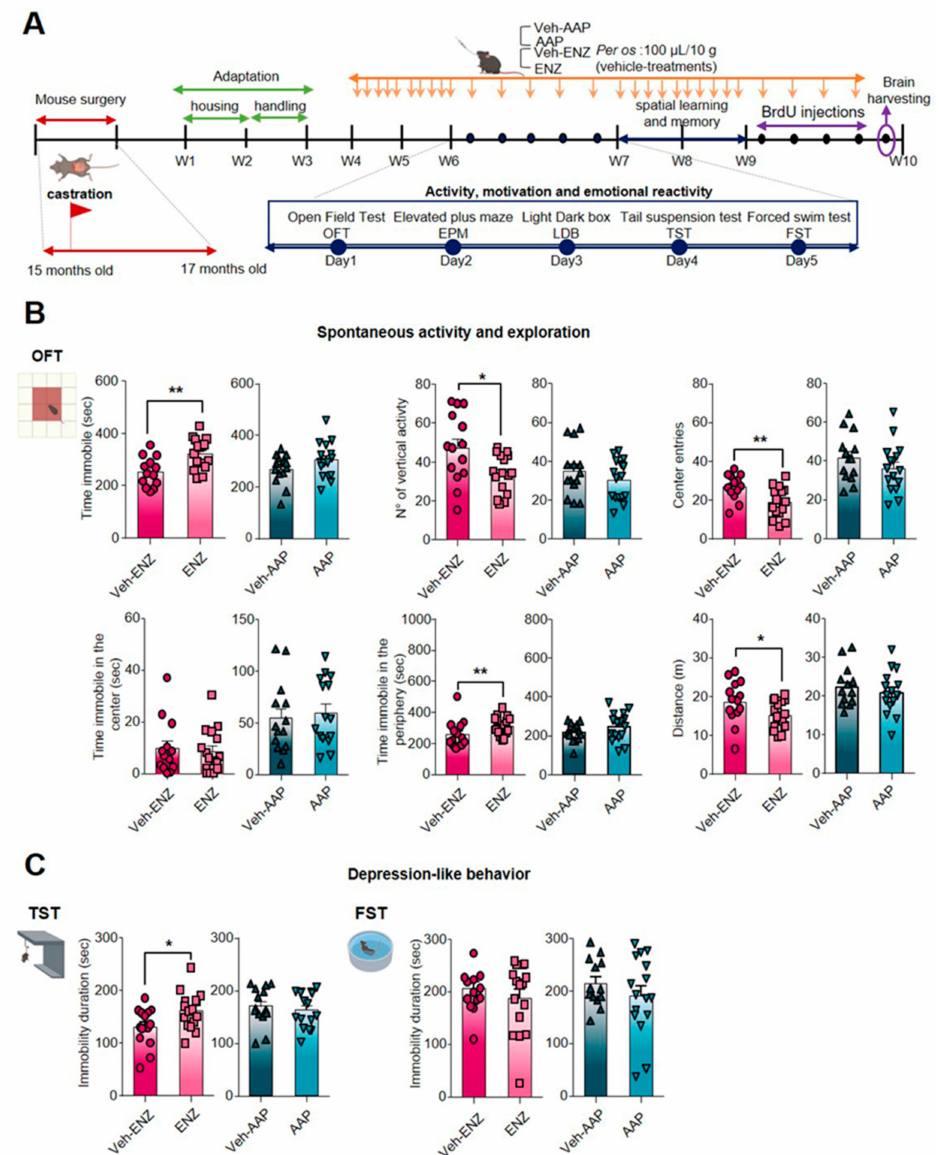
Figure 2. Characterization of ENZ or AAP impact on incentive exploratory behavior and motivation to the effort of mice. Note. ( A ) Schematic diagram showing the timeline for treatments and behavior experiments for ENZ and AAP treatments. Note. C57BL/6J Rj mice were castrated at 15 months old, were housed under controlled environment from 17 months old, while treatments were administered orally (per os) once a day for five per week, from week 4 (W4) to week 10 (W10), as indicated (orange arrow). Behavioral evaluations (blue arrow) started at W6, using an open-field test (OFT) on D1, elevated plus maze (EPM) on D2, light-dark box (LDB) on D3, tail suspension test (TST) on D4 and forced swim test (FST) D5. Mice brain and plasma were collected (purple arrows) at the end of W10 after the cognitive evaluation session. ( B , C ) Impact of ENZ or AAP compared with vehicle on spontaneous activity and exploration in OFT and on resigned behavior/motivation to effort in TST (left) and FST (right panel). Behavioral statistical analyses were performed between vehicle ( n = 14) and treated ( n = 16) mice using unpaired t-test or Mann–Whitney test; Bars are mean ± SEM while symbols individual data points; * p ≤ 0.05, ** p ≤ 0.01. AAP, abiraterone acetate-prednisone; D, day; ENZ, enzalutamide; EPM, elevated plus maze; FST, forced swim test; LDB, light-dark box; OFT, open-field test; TST, tail suspension